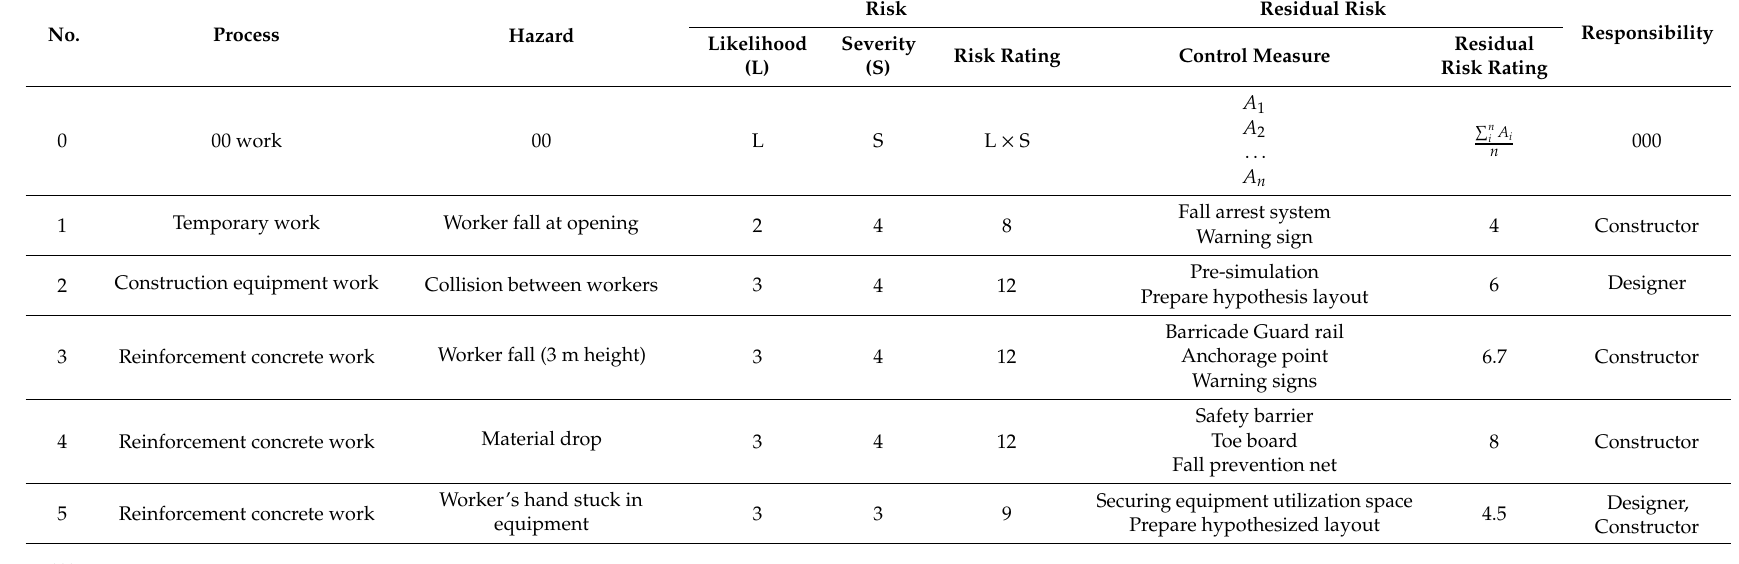
Table 9. Result of BIM-based risk assessment for design-for-safety